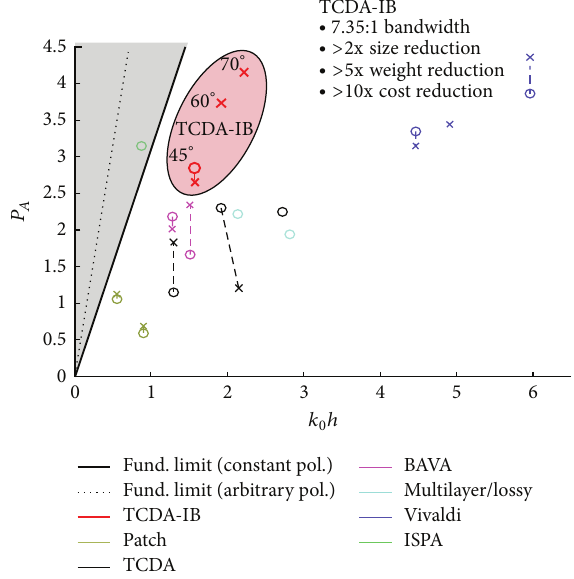
Figure 1: Performance factors of selected dual-pol. arrays, alongside fundamental limit from [56]. Here, 𝑃 𝐴 is a factor proportional to the antenna’s bandwidth, 𝐵 , with penalizations due to mismatches when measured or computed at the scan angle 𝜃 max . Γ max refers to the maximum reflection coefficient at the feed across thebandwidth. Note that the symbol “O” refers to broadside performance and symbol “X” refers to the bandwidth performance at the scanning angle of the array as indicated in the figure (see [58] for details). Qualitatively, when the plot symbol is closer to the theoretical optimal line, the antenna’s performance is also closer to having optimal